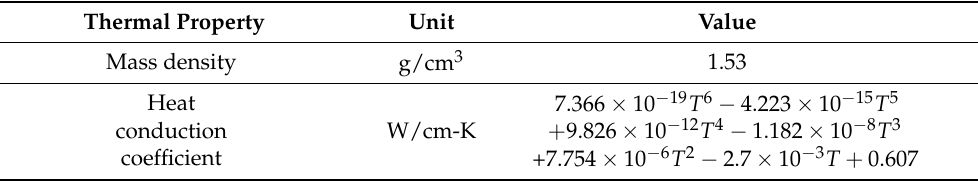
Table 2. Thermal properties of standard fuel blocks in the TREAT (300 K to 1200 K) core [43]. Thermal